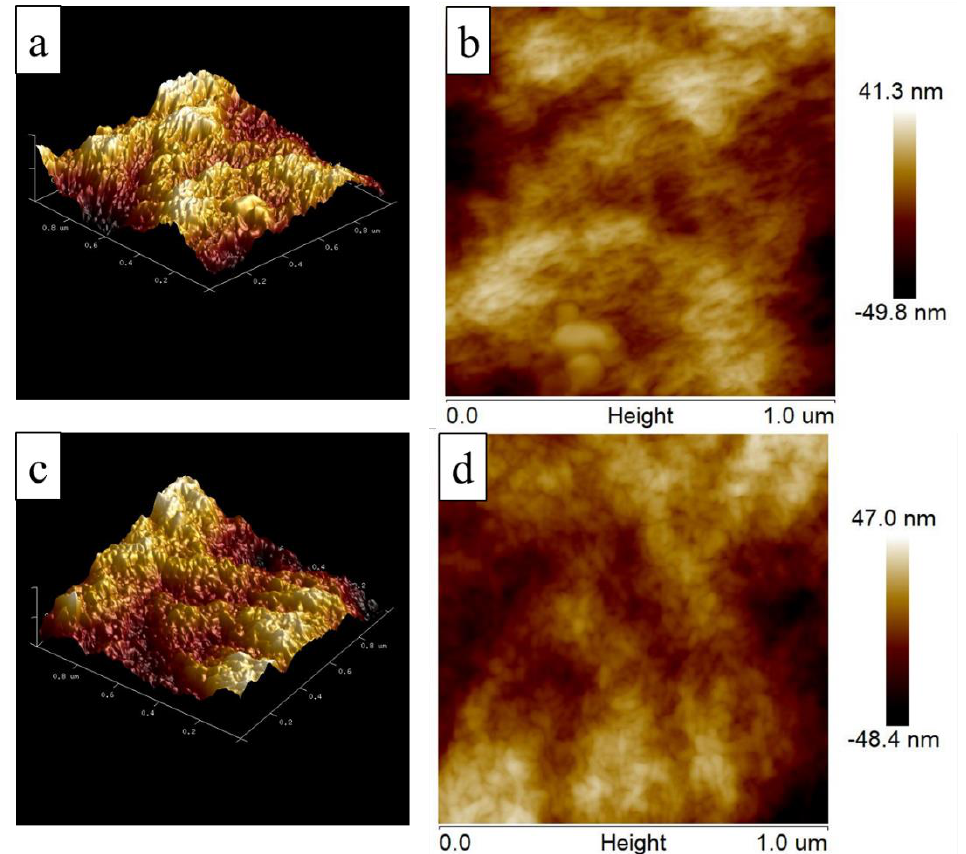
Figure 5. ( a , b ) The surface AFM images of an ANF membrane, ( c , d ) The surface AFM images of an ANF/HANF membrane (HANF composition: 10 wt%). Table 1. The roughness parameters of the ANF membrane and ANF/HANF membrane (HANF composition: 10 wt%).